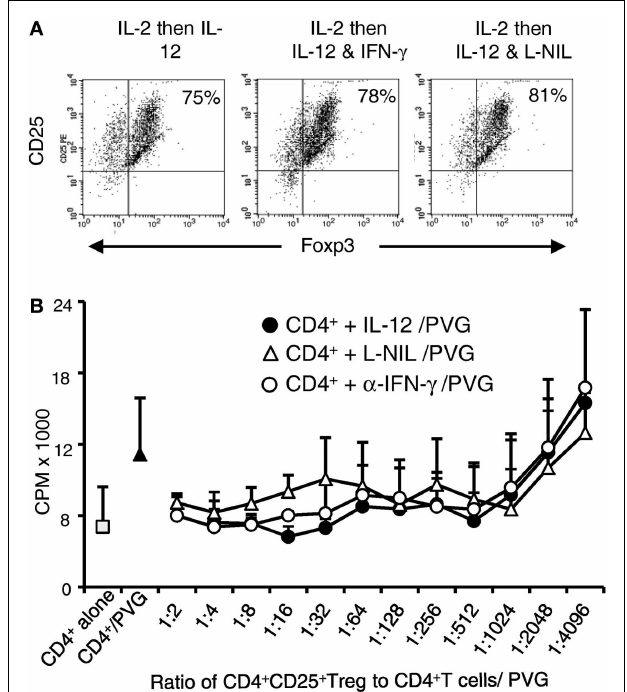
FIGURE 5 | Blocking IFN- γ or iNOS had no effect on alloantigen/ IL-12p70 mediated enhancement of suppressive ability ofTs1 cells:Ts1 cells generated by culture of nTreg with PVG alloantigen and rIL-2 for 3days were re-cultured with PVG alloantigen and either rIL-12p70 alone, rIL-12p70, and anti-IFN- γ (DB-1) or rIL-12p70 and L-NIL . After culture (A) Foxp3 expression was maintained in all cultures with 75–81% expressing both CD25 and Foxp3.The starting nTreg andTs1 populations had 70–80% Foxp3 + with nearly all were CD4 + CD25 + . (B) Blocking either IFN- γ or iNOS had no effect on the capacity ofTs1 cells re-cultured with rIL-12p70 and PVG stimulators to suppress naïve CD4 + T cell proliferation in MLC against specific PVG stimulators as measured by 3 H-thymidine incorporation (cpm × 10 3 ). MLC was significantly suppressed to or below background proliferation of control CD4 + T cells with no allogeneic stimulator (1.69 + 1.2 × 10 3 cpm).Ts1 cells re-cultured with specific PVG stimulators and rIL-12p70 alone ( • ) had significantly suppressed proliferation of CD4 + T cells to PVG stimulators at all ratios of 1:4 through to 1:1024 ( p < 0.02); forTs1 cells re-cultured with rIL-12p70 and anti-IFN- γ ( ◦ ), p < 0.015 to 1:512, and p = 0.02 at 1:1024.Ts1 re-cultured with rIL-12p70 and L-NIL ( (cid:52) ) significant differences were from 1:4 through to 1:512; p < 0.004 except for 1:64 and 1:128.These results suggested rIL-12p70 directly acted onTs1 cells, not via induction of IFN- γ and iNOS.